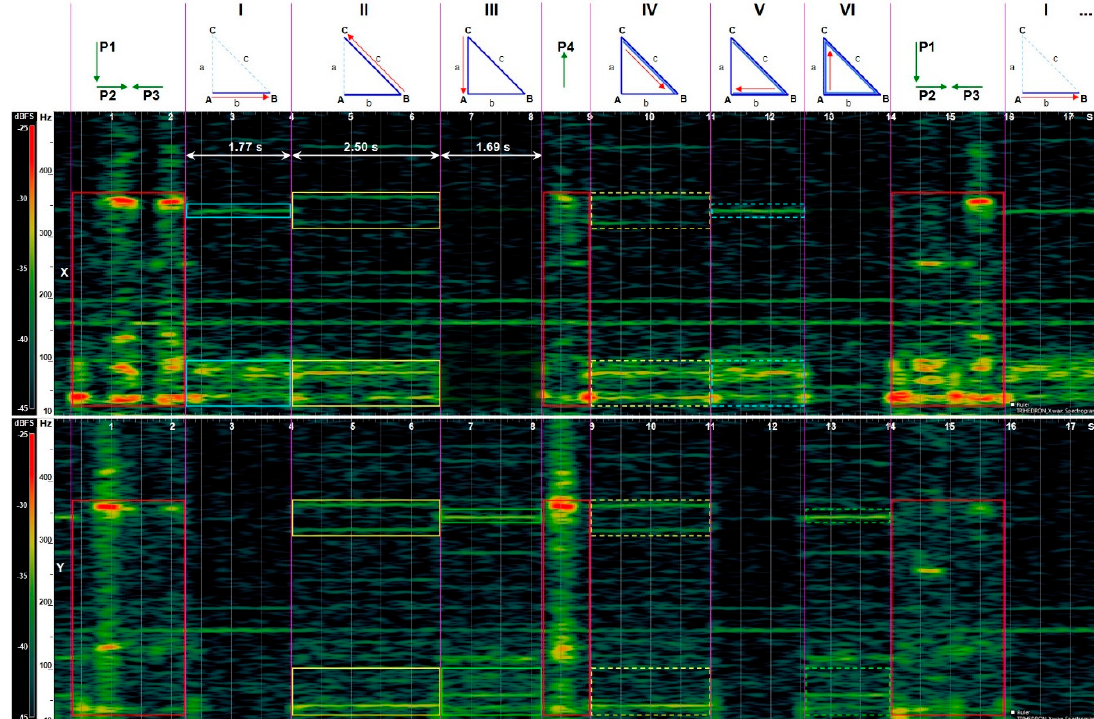
axis motion of the printhead.